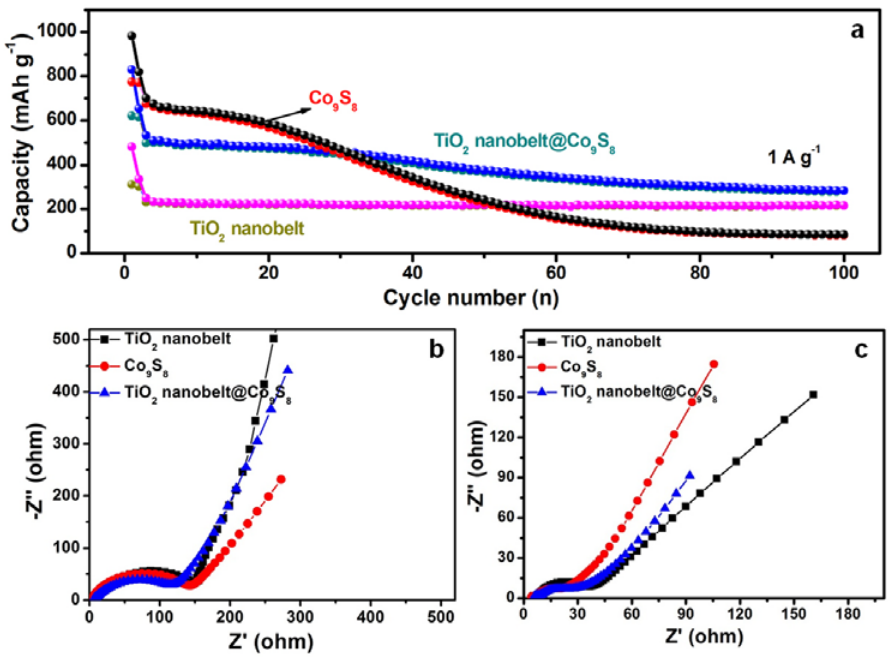
Figure 5. Cycling performances ( a ), electrochemical impedance spectra (EIS) of TiO 2 nanobelts, Co 9 S 8 nanoparticles and TiO 2 nanobelt@Co 9 S 8 composites: before cycling ( b ), and after cycling (c).